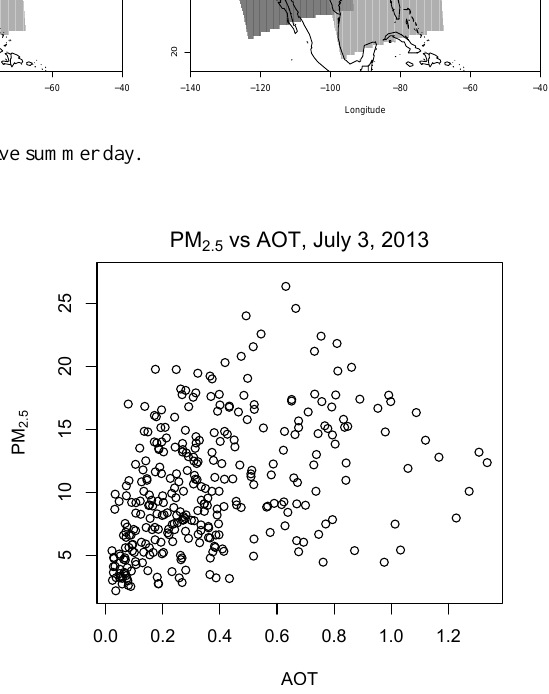
Figure 4. PM 2 . 5 vs. AOT on 3 July 2013. Spearman’s ρ correla- tion is 0.47, which was computed using the 522 monitoring station locations that had both PM 2 . 5 and AOT observed on that